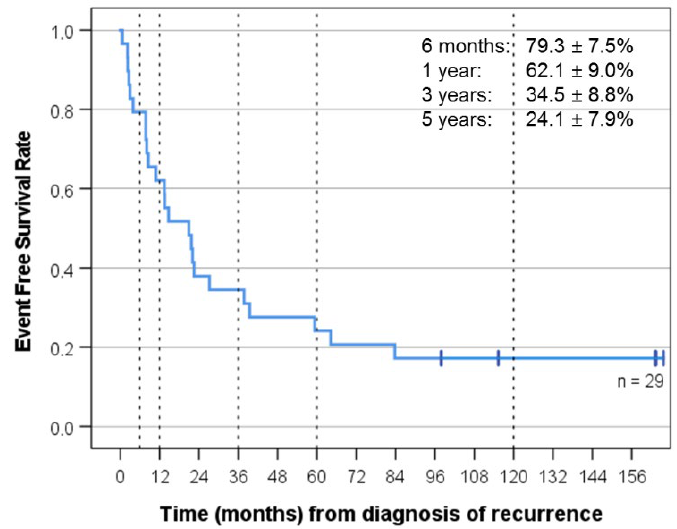
Figure 4. Event-free survival (EFS) for all 29 patients from time of diagnosis of recurrence that prompted MEMMAT-like therapy. Median EFS was 21.0 months (KI 7-35).